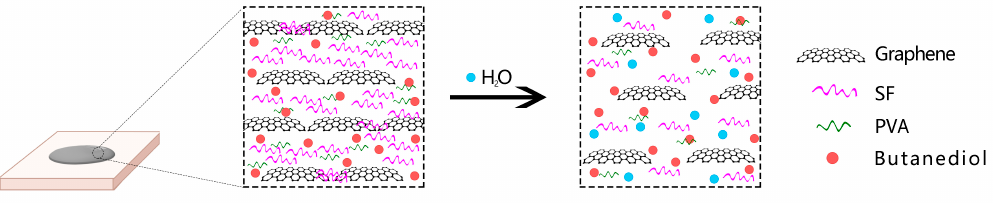
Figure 7. Swelling mechanism of SF/GrP/BD Film.